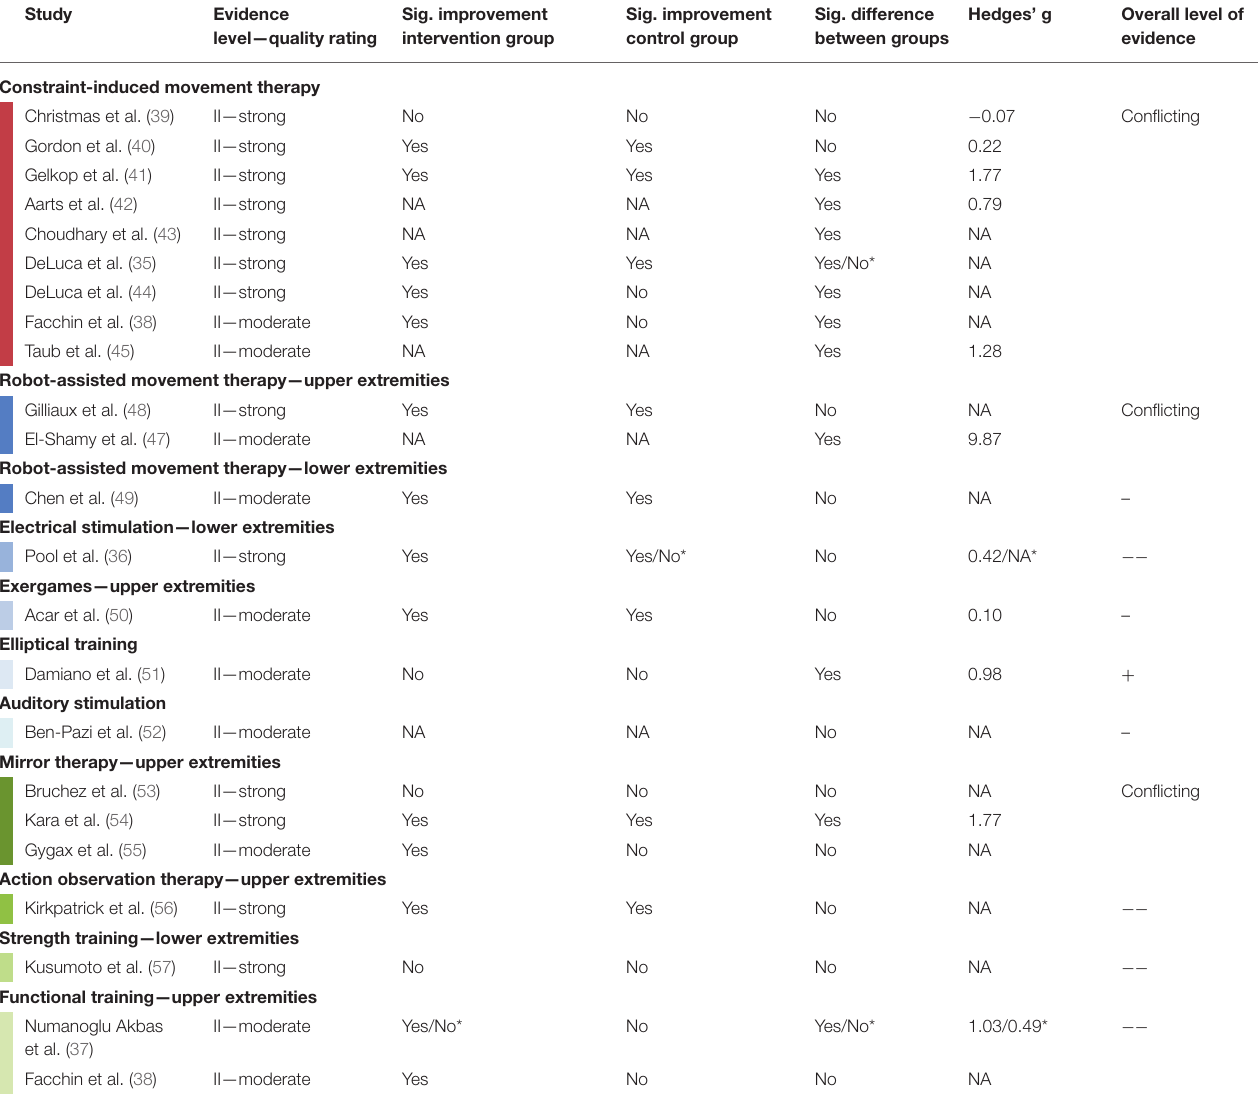
TABLE 5 | Summary of evidence and best evidence synthesis according to van Tulder et al. (28) of controlled group design studies with moderate or strong methodological